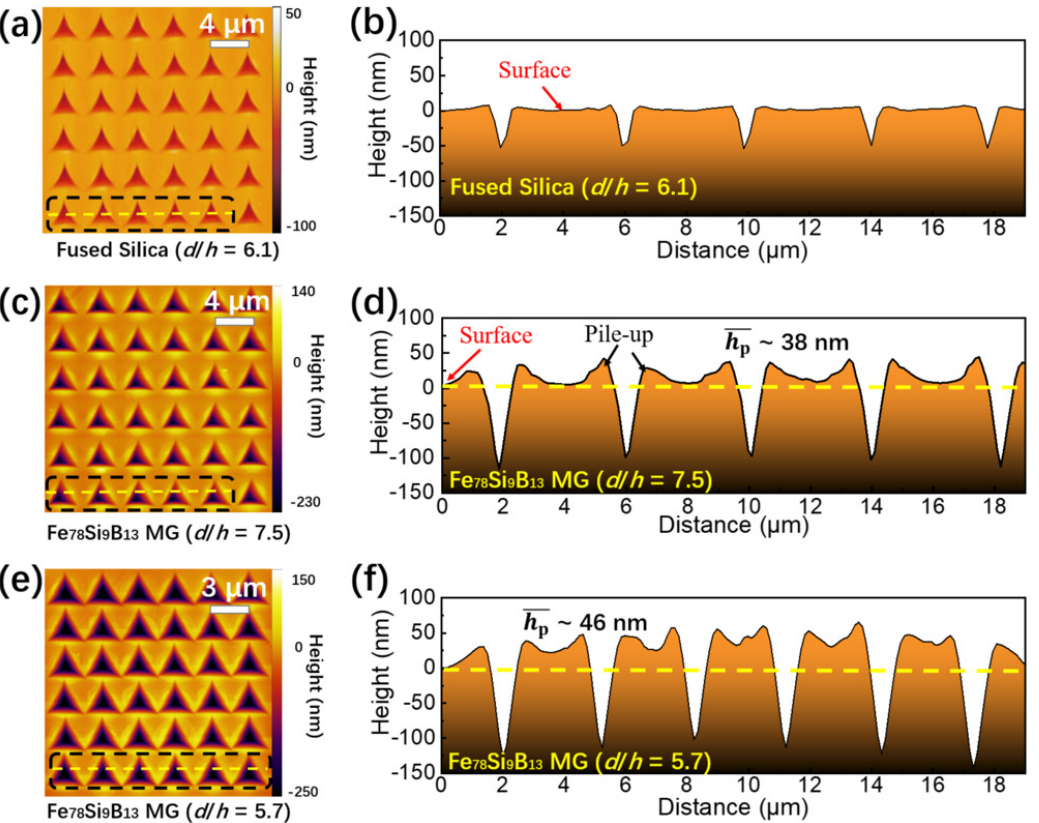
Figure 4. Morphology of the residual indentations obtained via atomic force microscopy analysis. ( a ) Height distribution of a 6 × 6 array on the fused silica ( d / h = 6.1) using atomic force microscopy scanning and ( b ) the corresponding profile of the indentations in the array along a line indicated in ( a ) within the black dotted box. Similar analyses of the Fe 78 Si 9 B 13 metallic glass ( d / h = 7.5 and 5.7) are presented in ( c – f ). The horizontal dashed lines in ( b , d , f ) represent the positions of the original sample surface before indentation. The pile-up height was defined as the maximum height above the original sample surface.